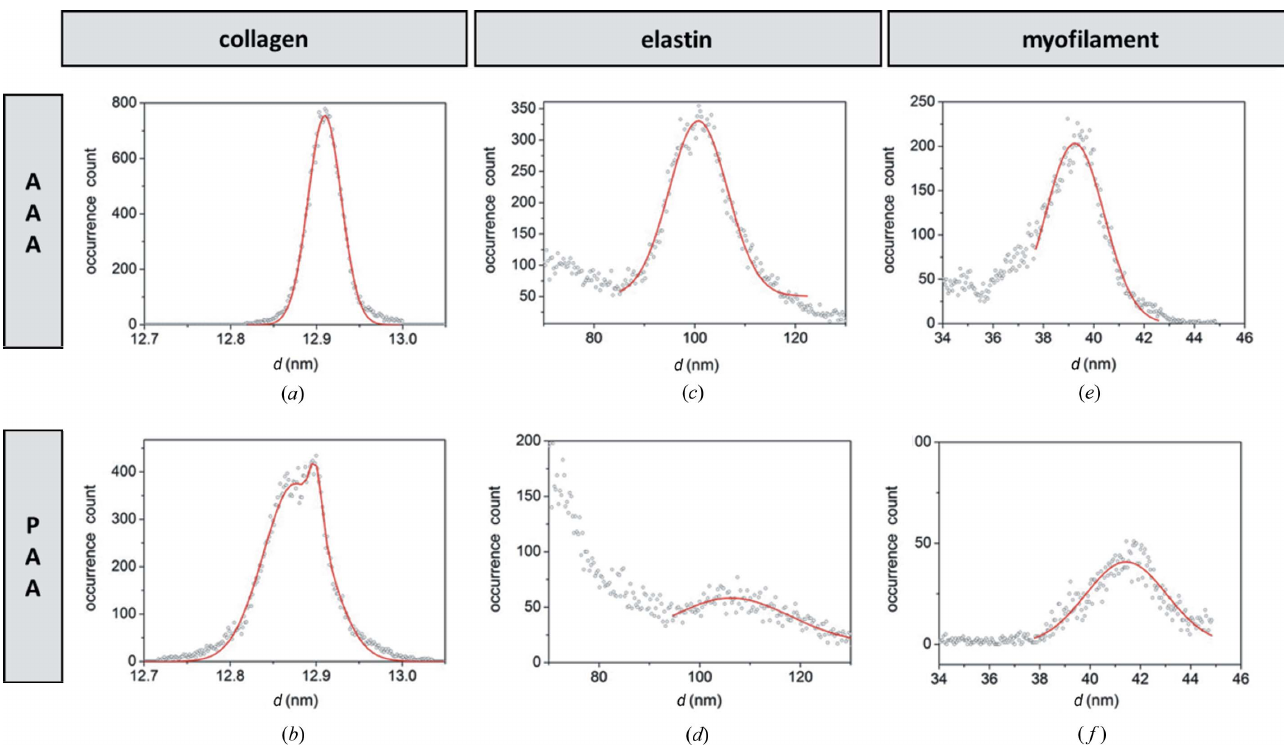
Figure 6 SAXS distribution of structural parameters of filaments. ( a ) Fifth-order collagen peak centered at 12.91 (cid:8) 0.02 nm for AAA and ( b ) fitted by two contributions at 12.87 (cid:8) 0.04 nm and 12.90 (cid:8) 0.01 nm for PAA; ( c ) the elastin-fibril-diameter distribution is centered at 101 (cid:8) 6 nm for AAA and ( d ) 106 (cid:8) 11 nm for PAA; ( e ) the myofilament lattice spacing is centered at 39 (cid:8) 1 nm for AAA and ( f ) 41 (cid:8) 2 nm for